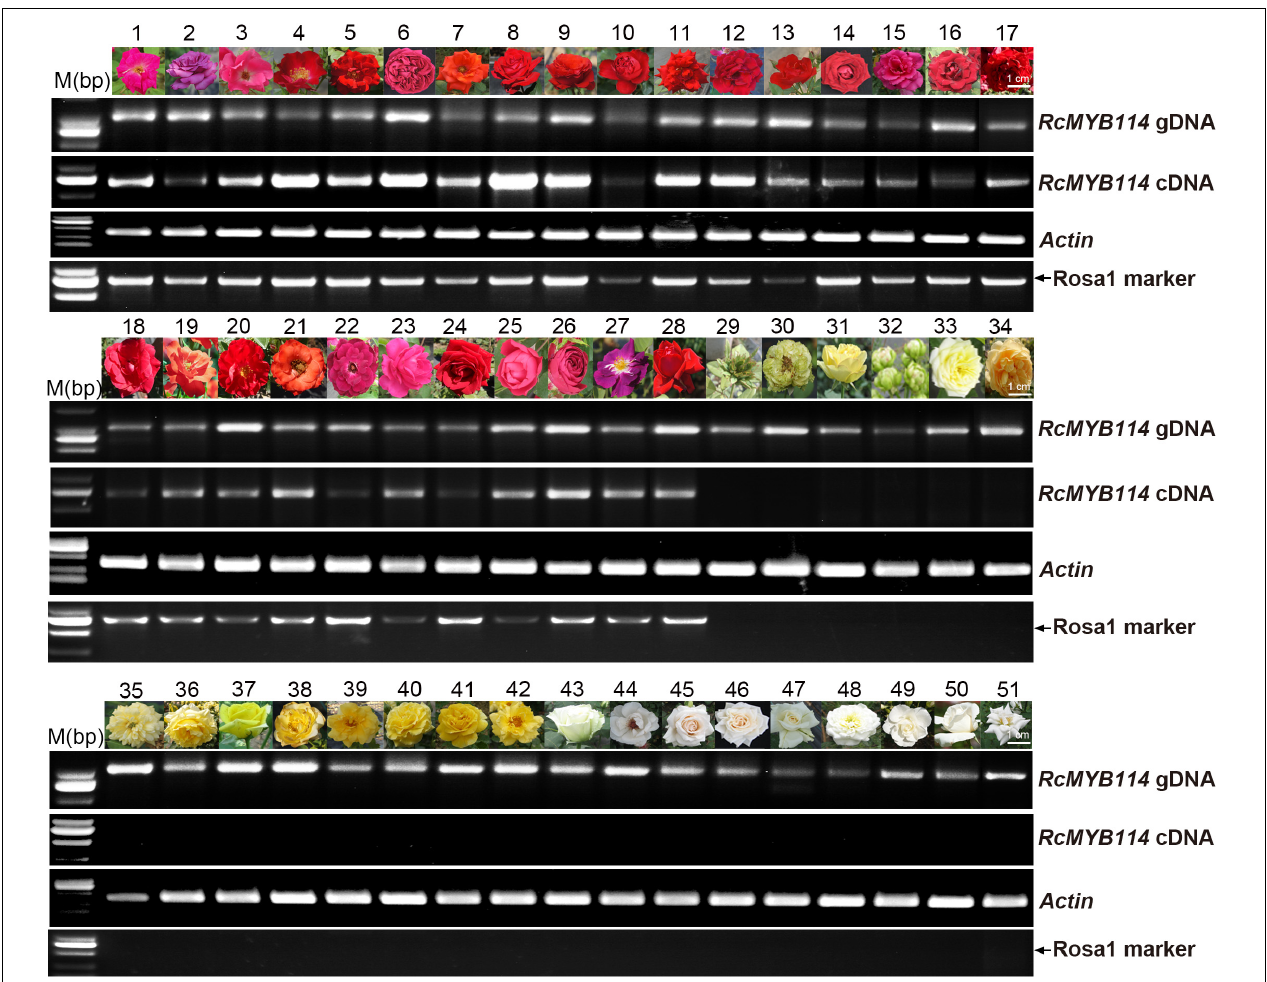
FIGURE 4 | Expression of RcMYB114 across different petal-color phenotypes is dependent on the presence of Rosa1 transposable element-like sequence within the upstream regulatory sequence of RcMYB114. PCR amplification of RcMYB114 from genomic DNA and petal cDNA of 51 rose varieties. Actin was used as a loading control. Only the red-petal varieties contained the Rosa1 transposable element-like